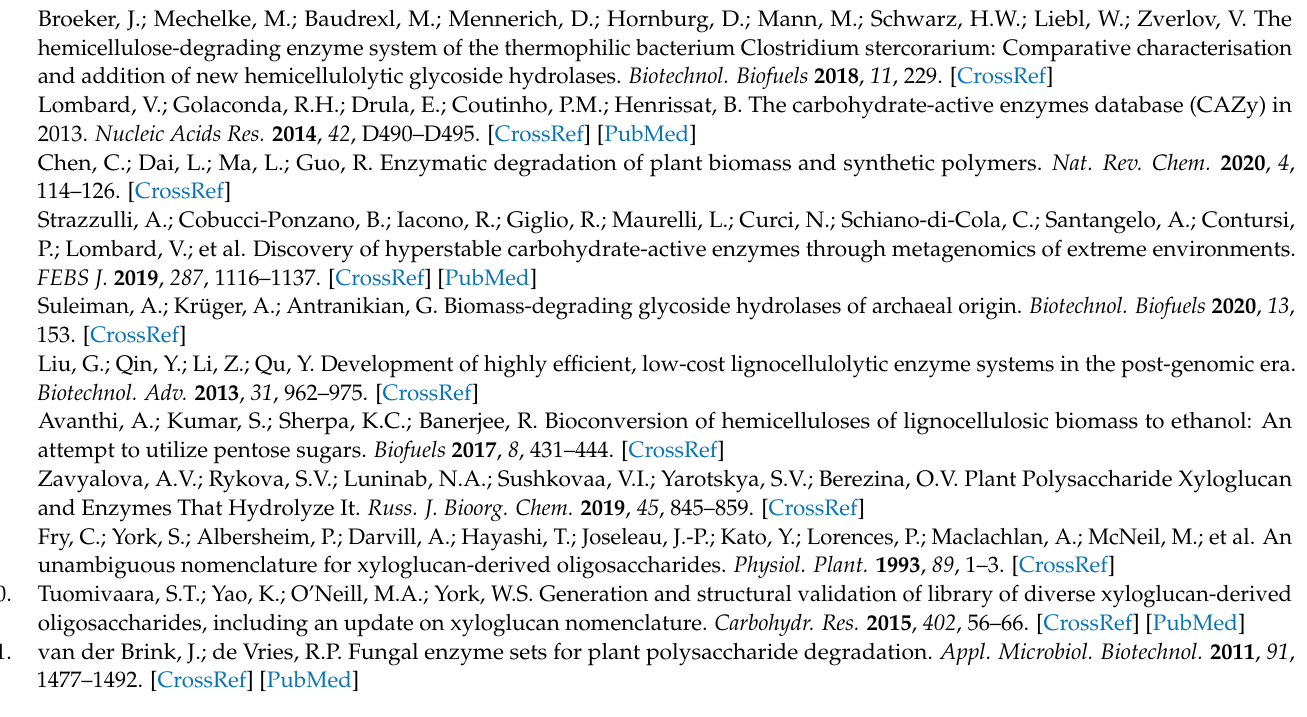
Table S1. Monosaccharides composition from the time course of the enzymatic treatment of XGO1 by using LacS 2.2 U and XylS 0.1 U. Table S2. Monosaccharides composition from the time course